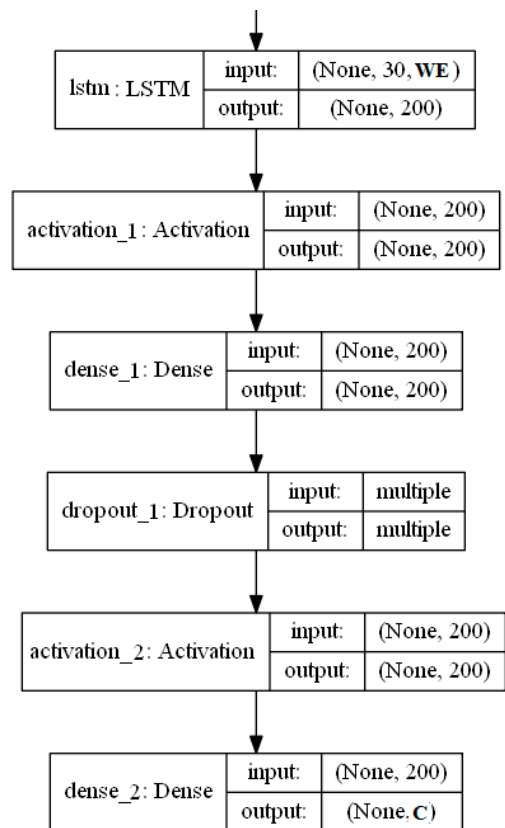
Figure 4. The optimal bidirectional long short-term memory method (BiLSTM) model architecture on chatbot and webapps datasets for the English language, with X1 = 800 and X2 = 300 on chatbot and X1 = 400 and X2 = 200 on webapps .